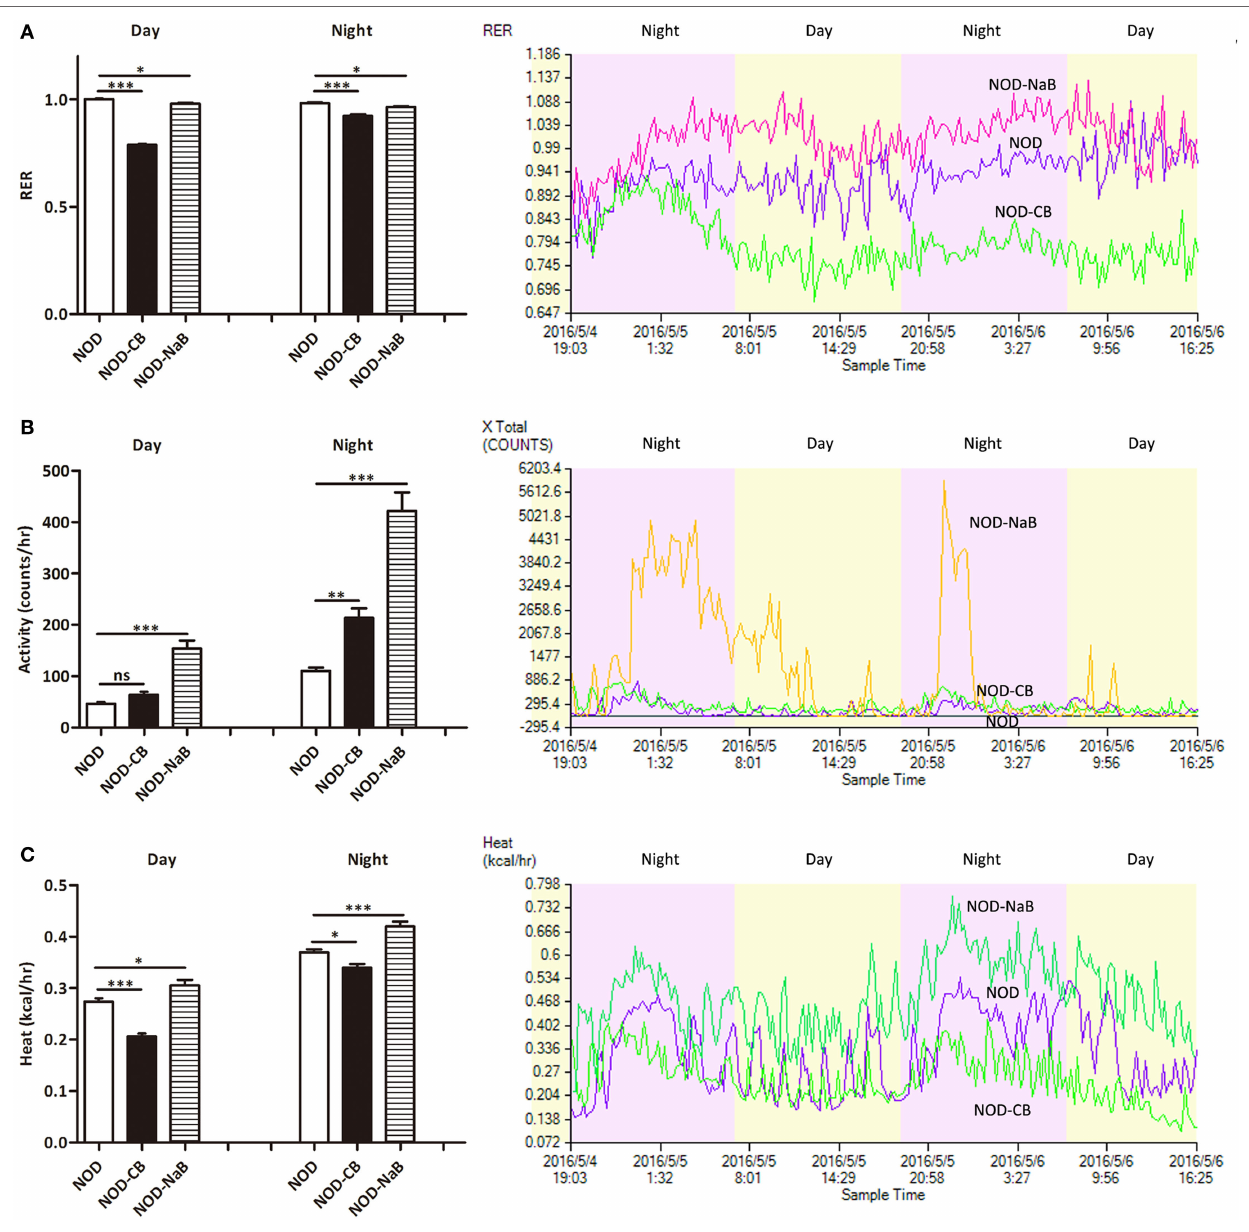
FigUre 2 | CB0313.1 but not butyrate improves energy metabolic dysfunction. Energy metabolism was examined using a metabolic chamber at 12 weeks of age. (a) Substrate utilization is expressed as the respiratory exchange ratio (RER), the ratio of O 2 consumption to CO 2 exhalation volume; (B) spontaneous physical activity; (c) heat production. Data are mean ± SEM ( n = 4 mice per group). Analysis of variance followed by the indicated post hoc test was performed to determine the significance among the three groups. t -test was used for two independent groups. *, **, *** p < 0.05, p < 0.01, p < 0.001 vs NOD control